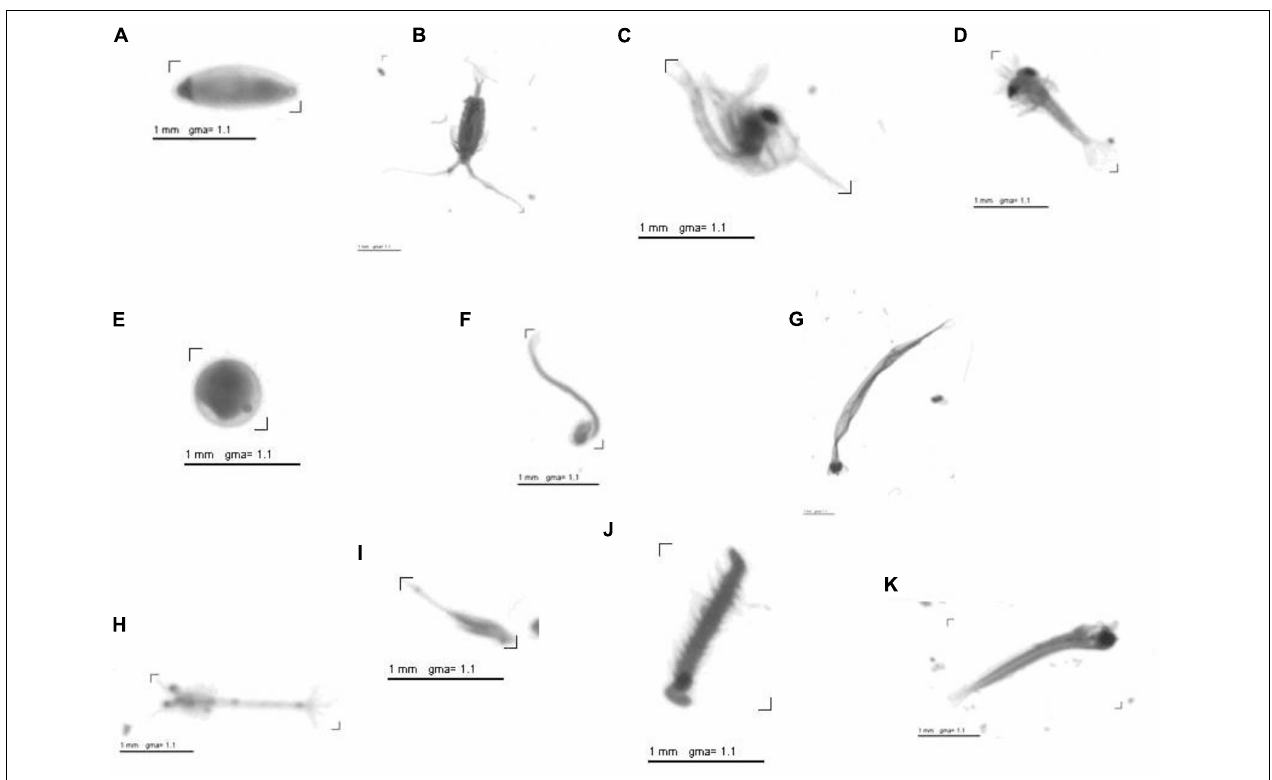
FIGURE 5 | Examples of scanned objects (vignettes) (A) Ostracoda (Oligostraca), (B) Calanoida (Copepoda), (C) Zoea (Decapoda), (D) Zoea (Decapoda), (E) Egg, (F) Appendicularia (Tunicata), (G) Chaetognatha (Metazoa), (H) Zoea (Decapoda), (I) Harpacticoida (Copepod), (J) Polychaeta (Annelida), (K) Fish Larvae.